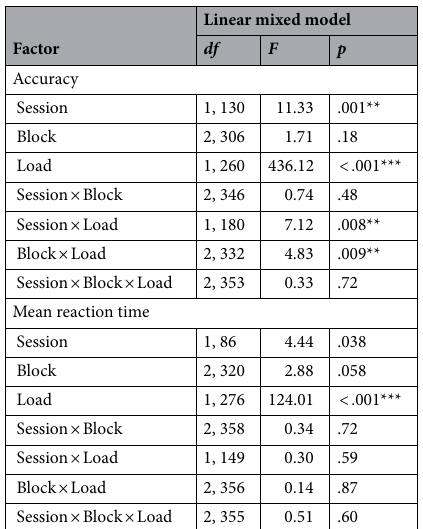
Table 2. Linear mixed model results for accuracy and mean reaction time. Asterisks indicate significant effects that survived false discovery rate correction. ** p < .01, *** p < .001.